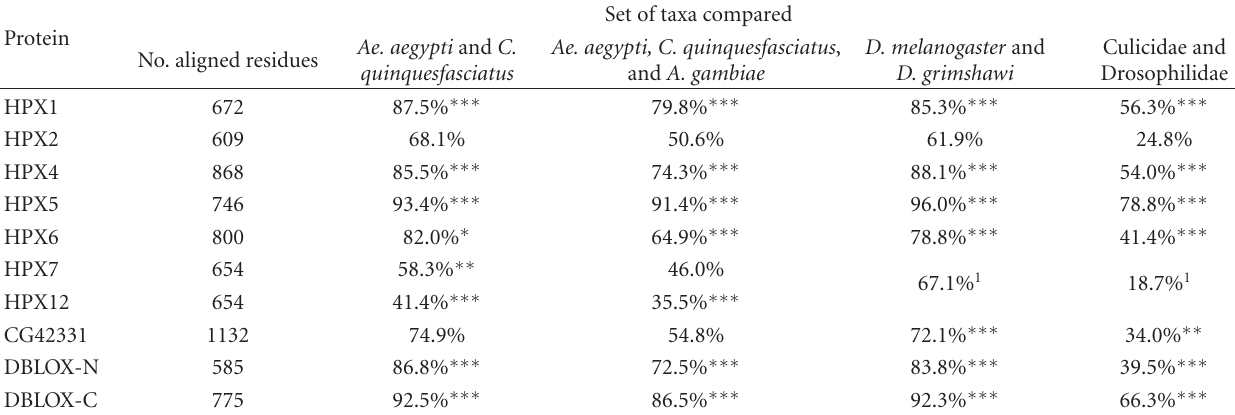
Set of taxa compared